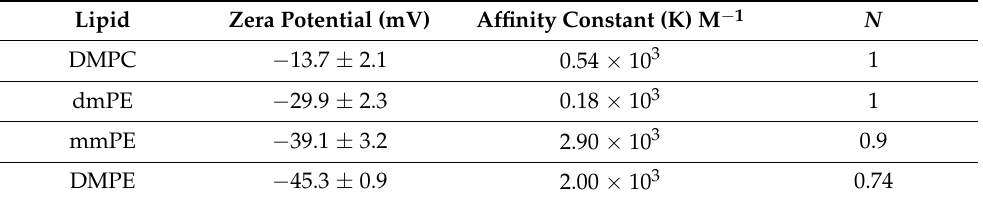
Table 1. Zeta potential, affinity constant and cooperativity coefficient as a function of the de methyla- tion of phosphocholine groups. Lipid Zera Potential